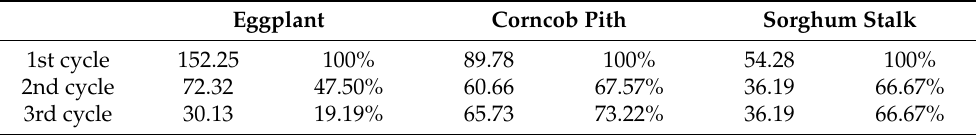
Table 2. Changeable methane adsorption capacity ( v / v ) of different biomaterials in three cycles. Eggplant Corncob Pith Sorghum Stalk 1st